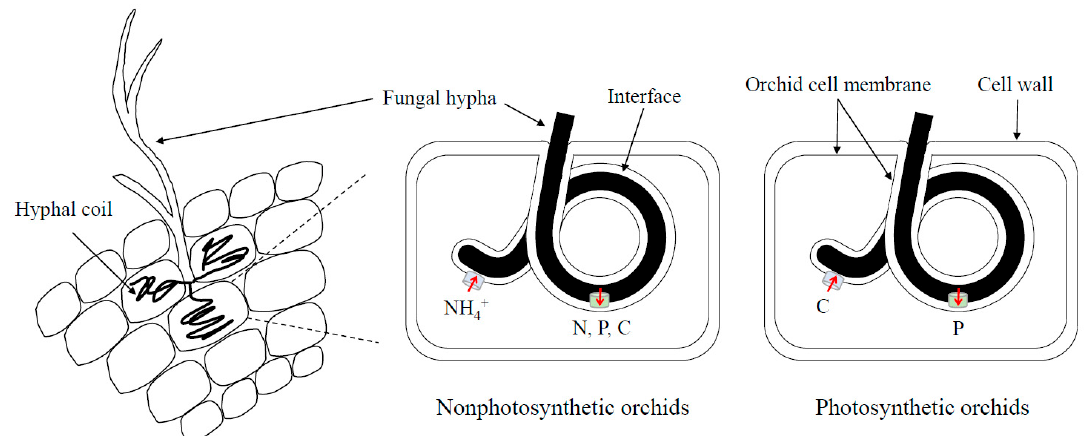
Figure 1. The possible model of nutrient exchange in orchid mycorrhizas. In natural conditions, orchid seeds form symbiosis with orchid mycorrhizal fungi to receive nutrients for germination and further protocorm development. The hyphae of orchid mycorrhizal fungi can enter orchid cells and form coiled complexes called pelotons. At nonphotosynthetic stages, orchid cells export ammonium (NH4+) to their fungal partners and receive nitrogen (N), phosphorus (P) and carbon (C) for germination. In addition, the senescent pelotons can also release N, P and C to orchid cells when hyphal coils are digested. After orchids develop green leaves, mycorrhizal fungi can obtain photosynthetically fixed C as a reward. However, photosynthetic orchids may not further receive N from fungal cells and only P is exchanged to orchid cells [29].